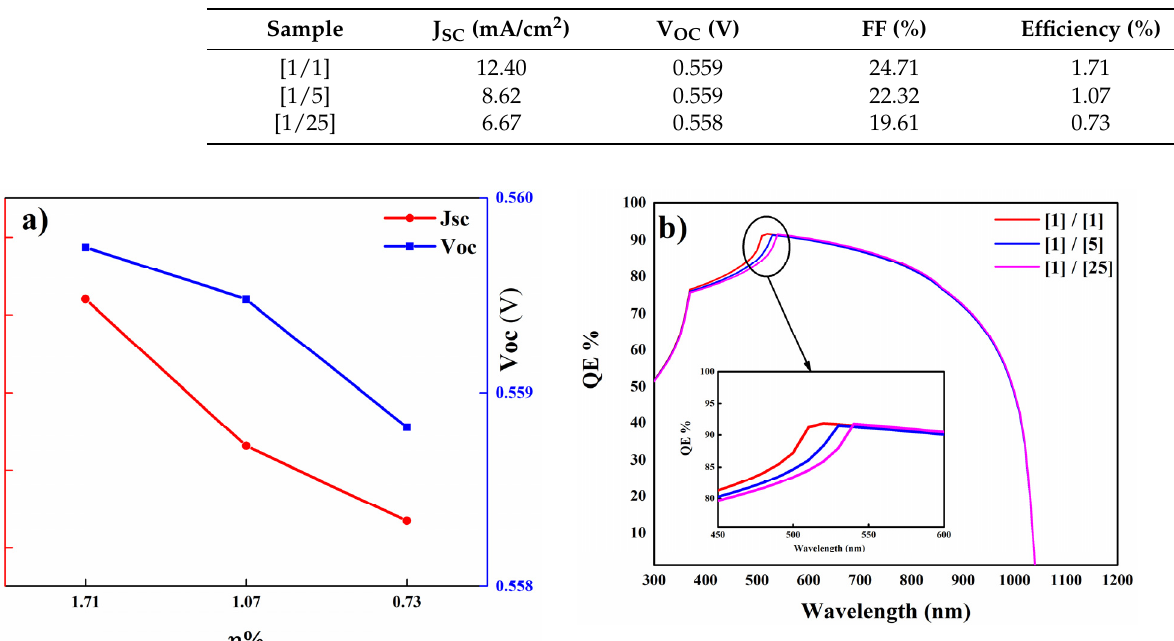
Table 6. Performance of CIGS solar cells with various Thiourea concentrations.